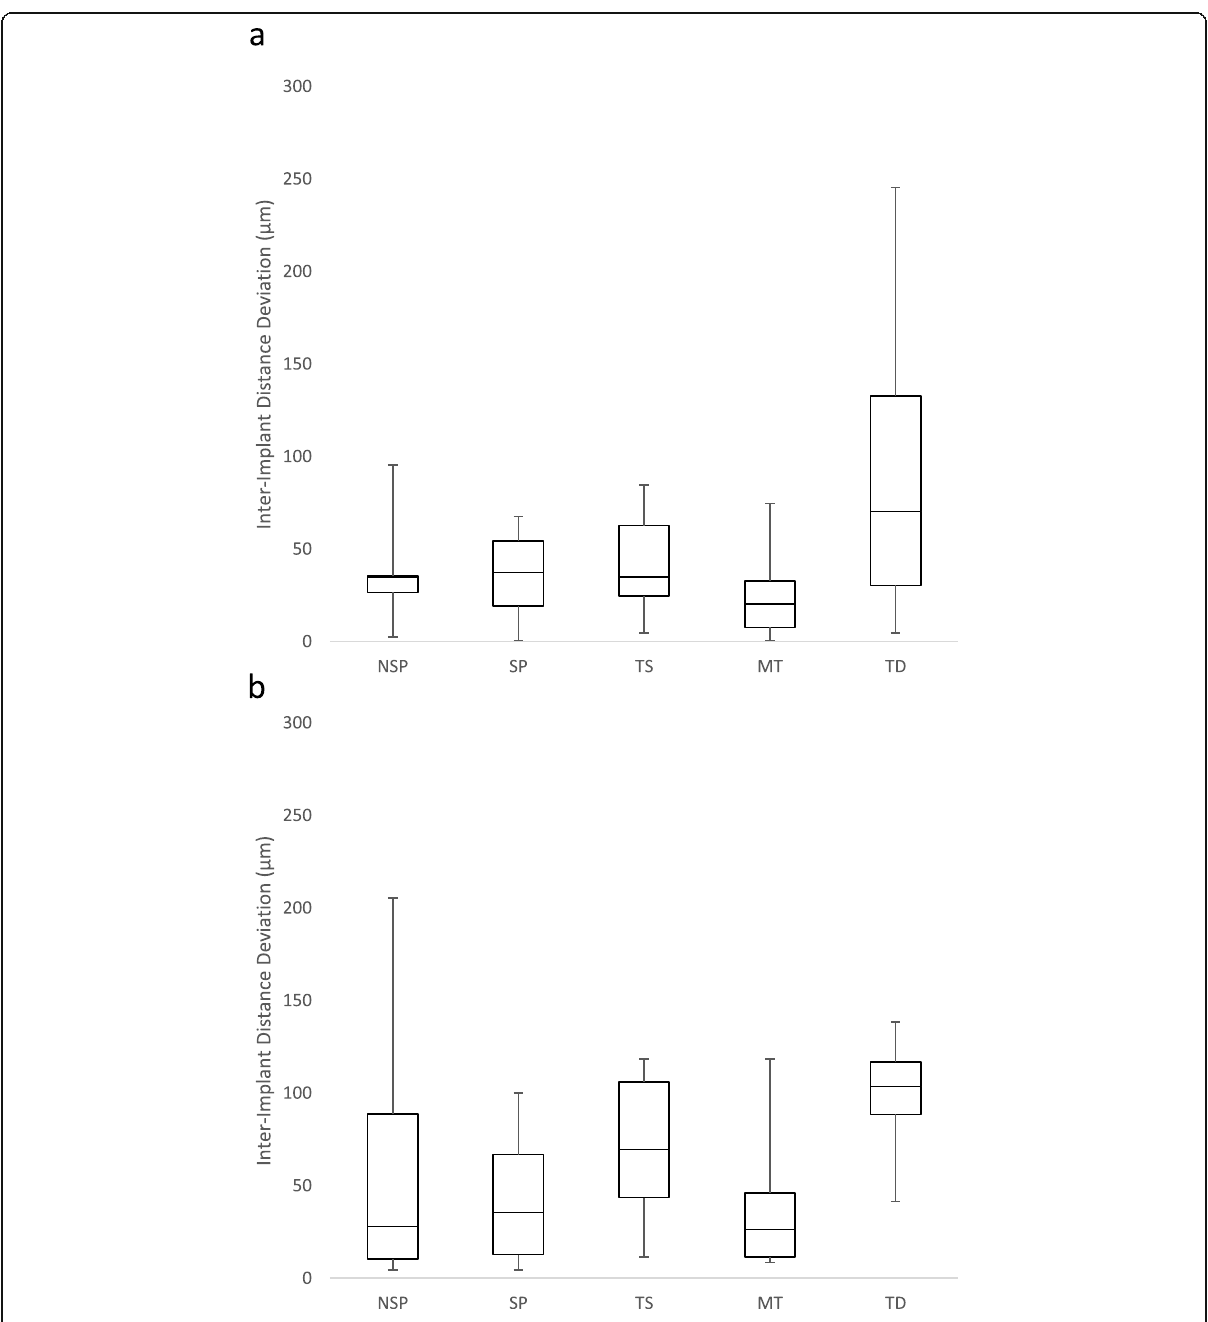
Fig. 5 Box plot diagrams of the inter-implant deviation of every impression technique. a Parallel implants model. b Divergent implants